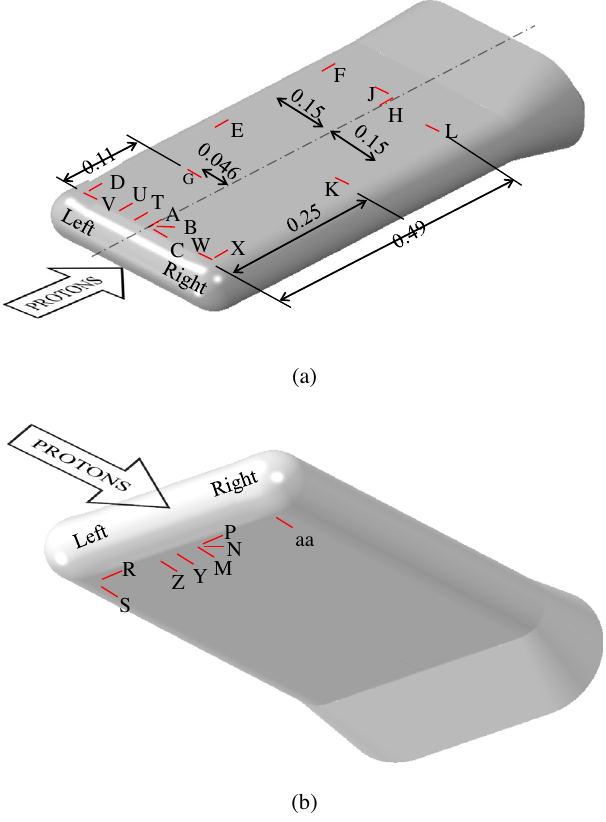
FIG. 7. Strain sensor positions and orientations on the mercury vessel top (a) and bottom (b)